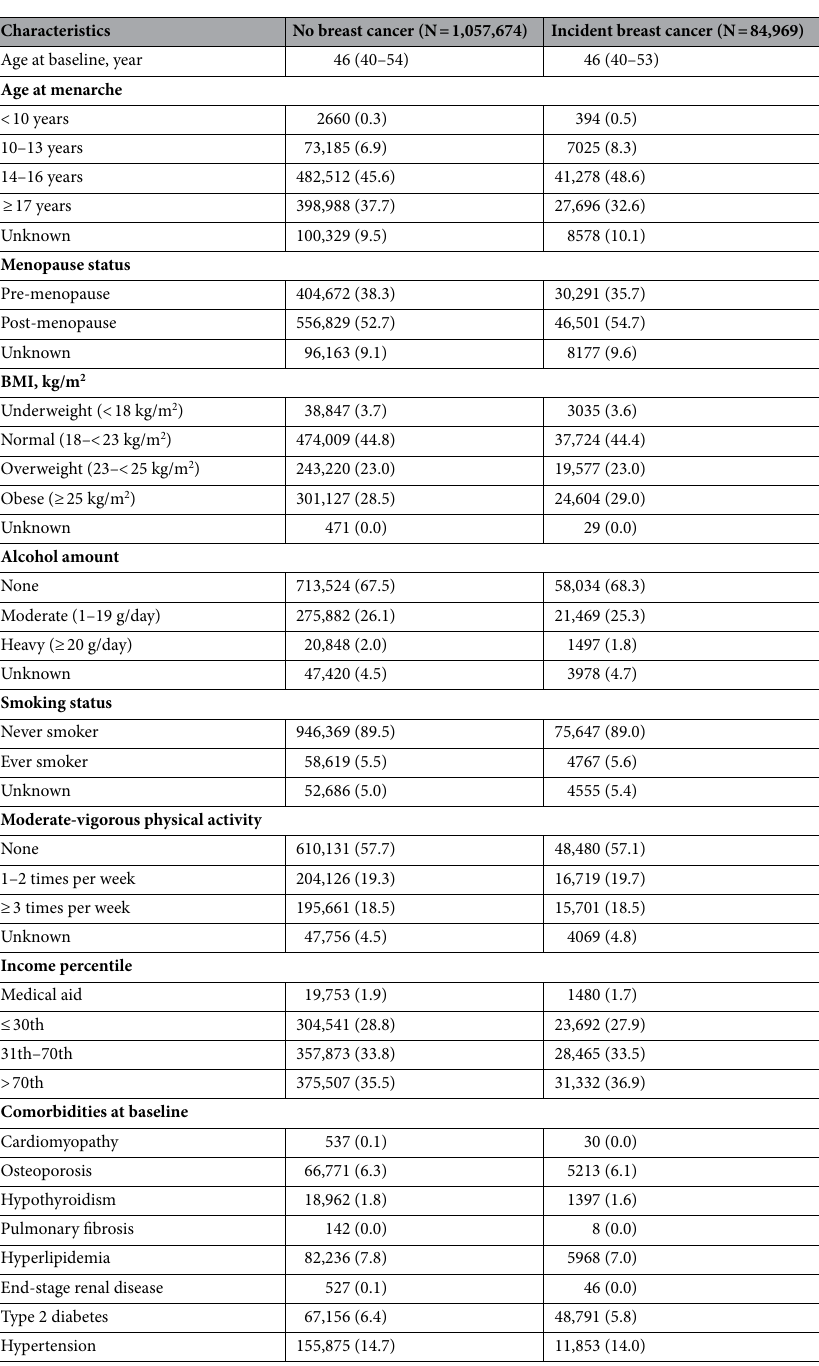
Table 1. Characteristics of study participants at the baseline health screening exam (N = 1,142,643). Values in the table are median (interquartile range) or number